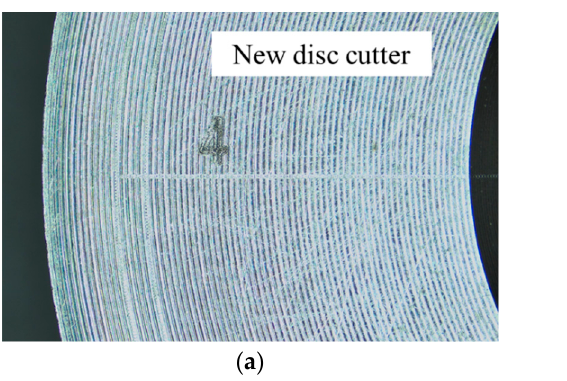
Figure 1. The schematic diagram of the disc cutter and its machining process.